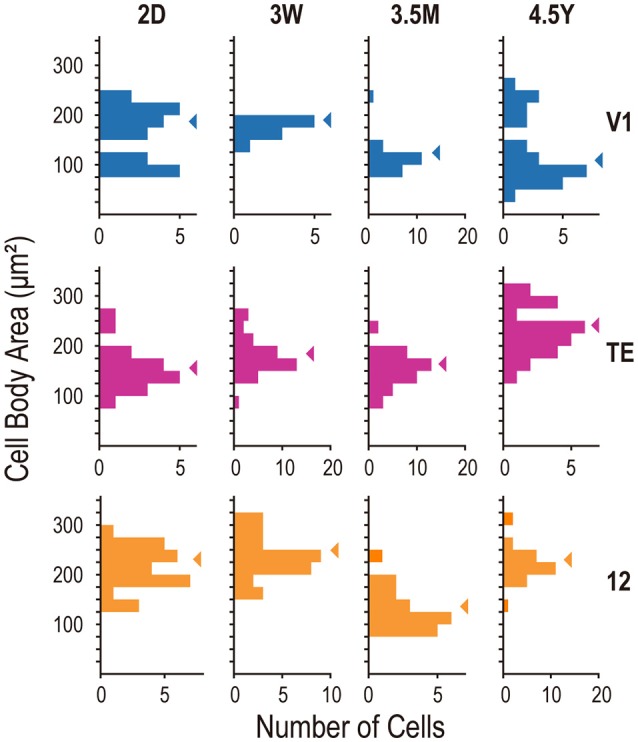
Frequency histograms of cell-body size of layer-V neurons from areas V1, TE, and area 12. Arrowheads indicate the medians.